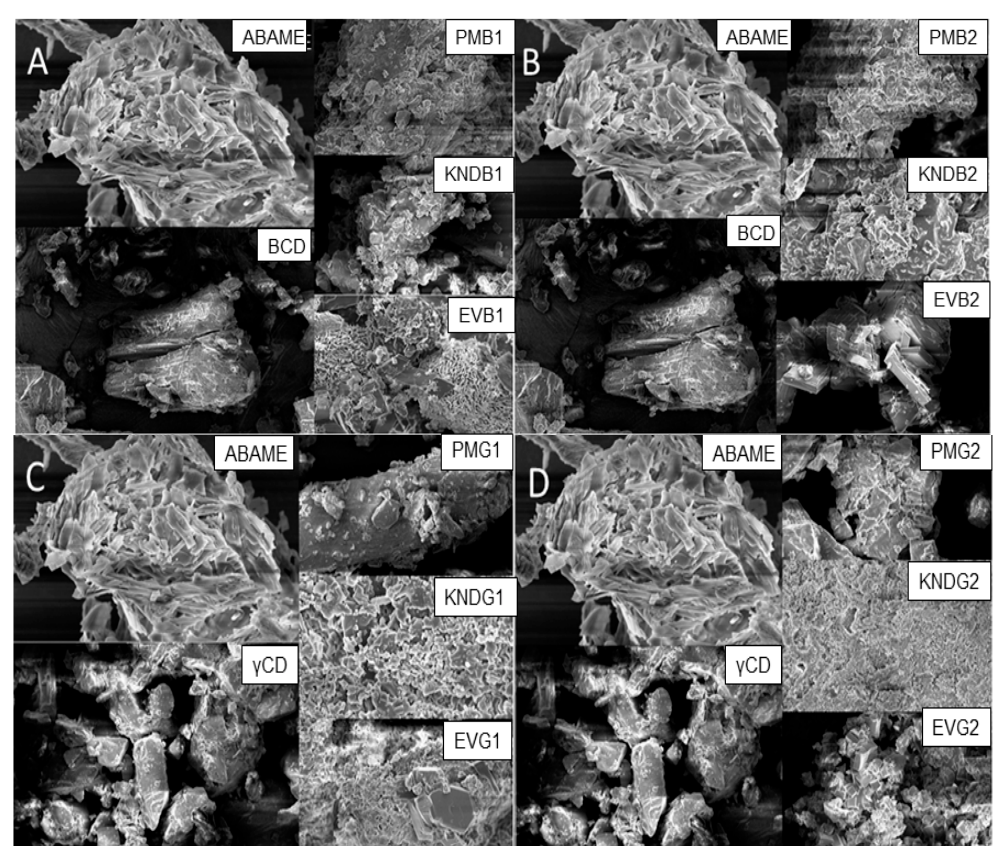
Figure 7. SEM micrographs of individual compounds, namely α , β -amyrenone (ABAME), β - cyclodextrin ( β CD) and γ - cyclodextrin ( γ CD), as well as inclusion complexes (ICs). ICs prepared with ABAME and β CD at 1:1 ( A ) and 2:1 ( B ) molar ratios using physical mixture (PMB1 and PMB2), kneading (KNDB1 and KNDB2), and rotary evaporation (EVB1 and EVB2), respectively. ICs prepared with ABAME and γ CD at 1:1 ( C ) and 2:1 ( D ) molar ratios using physical mixture (PMG1 and PMG2), kneading (KNDG1 and KNDG2), and rotary evaporation (EVG1 and EVG2), respectively.